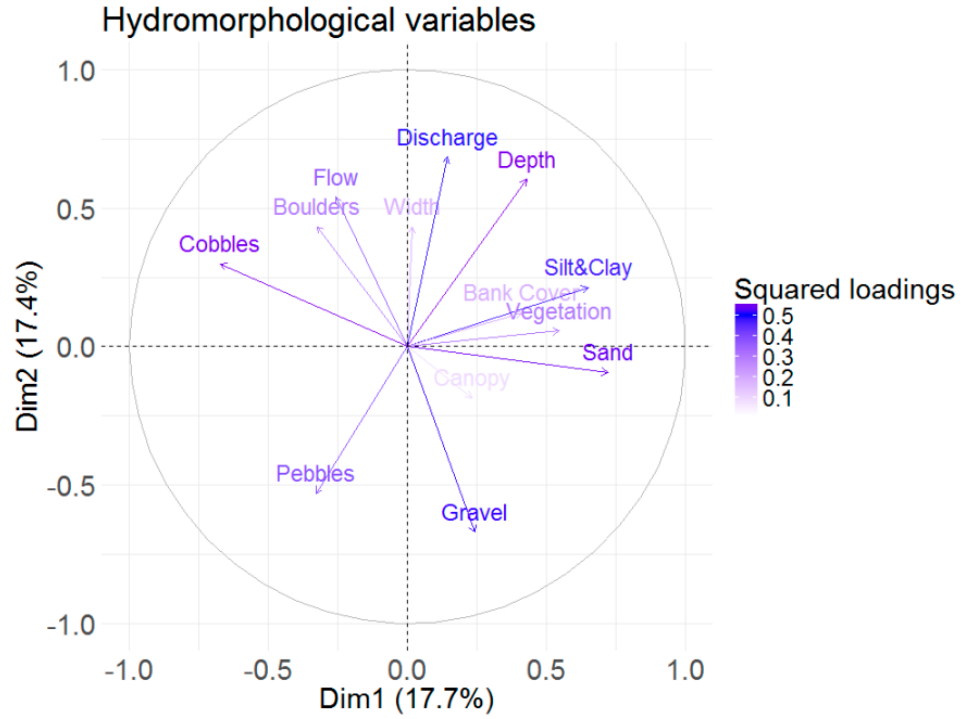
Figure 5. PCA factor map of the hydromorphological variables. Arrows represent the squared loadings of the variables. Color intensity is proportional to the value of the loading. Variables that are closer to the correlation circle contribute more to the principal components.